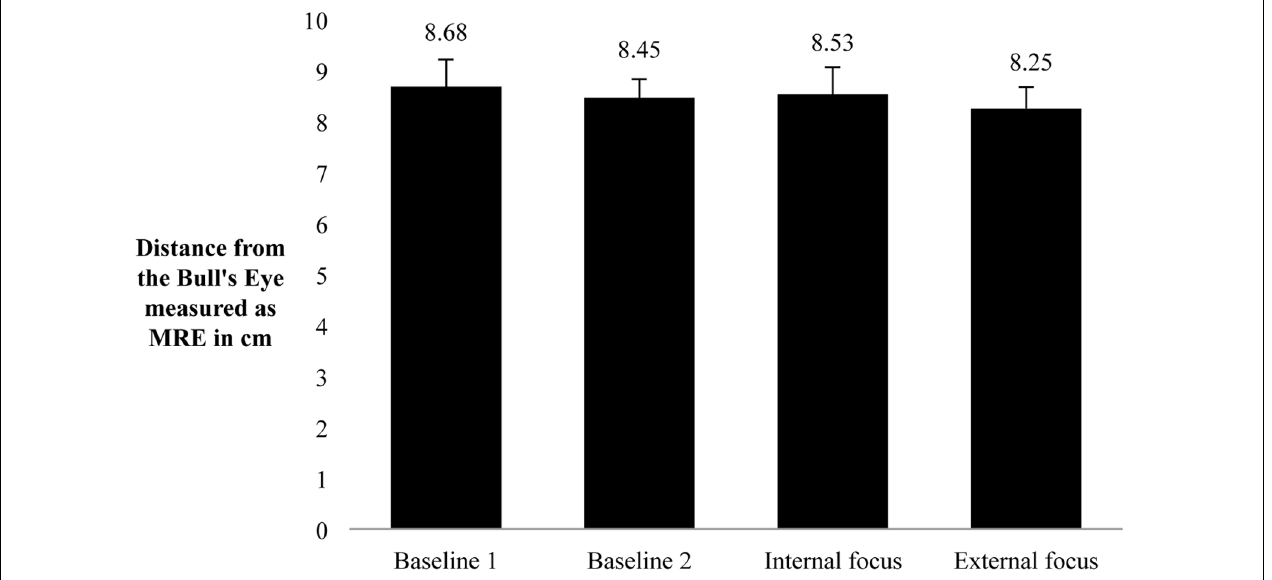
FIGURE 1 | Mean Radial Error (MRE) of dart performance for each condition. For baseline 1 (without gaze tracking), baseline 2 (with gaze tracking), internal and external focus conditions; error-indicators depicted are standard errors of the mean.